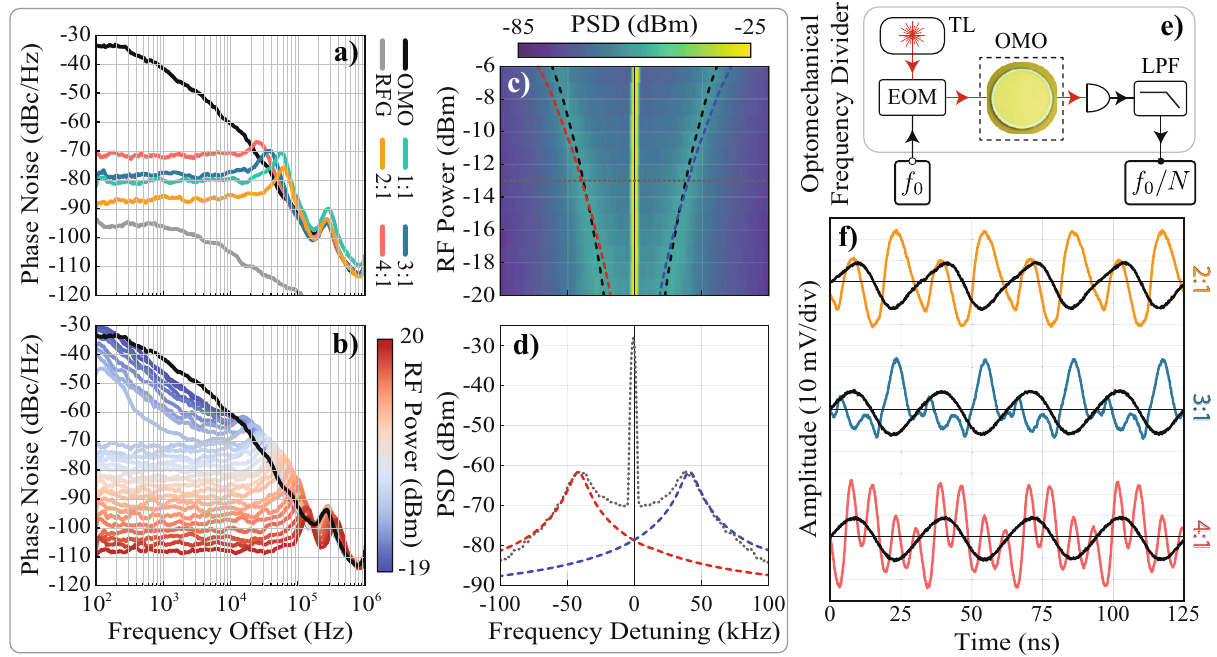
Fig. 4 Phase-noise reduction and optomechanical frequency division. a Measured one-sided phase noise spectral density for the free-running (black), injection-locked (colored), and RF injection signal (gray). The RF power used for the injections was − 7 dBm ( ε ≈ 5.5%); b Phase noise spectral density evolution as a function of the RF power for the 4:1 injection; c Comparison between experimental data sidebands and the semi-analytical model prediction (see Supplementary Note 7). The colormap is the experimental power spectral density (PSD) around the OMO fundamental frequency. The RF drive frequency was set to the OMO frequency for all the RF powers shown. The black dashed lines are the experimental fi t and the red/blue curves are the semi-analytical prediction, showing excellent agreement; d Experimental PSD, in gray, for a RF power of − 13 dBm ( ε ≈ 2.75%), which is the same horizontal dashed gray linecut at ( c ) showing the agreement between semi-analytical model and experimental data for these sidebands, for both frequency and linewidth; e Schematic of the optomechanical frequency divider; LPF means “ low-pass fi lter ” ; f Experimental Optomechanical frequency division. The orange, blue and red curves are the injection-locked signal output from the OMO for the cases 2:1, 3:1, and 4:1, respectively. The overlapping black curves are the divided signal obtained using a low-pass fi lter with 48 MHz cutoff